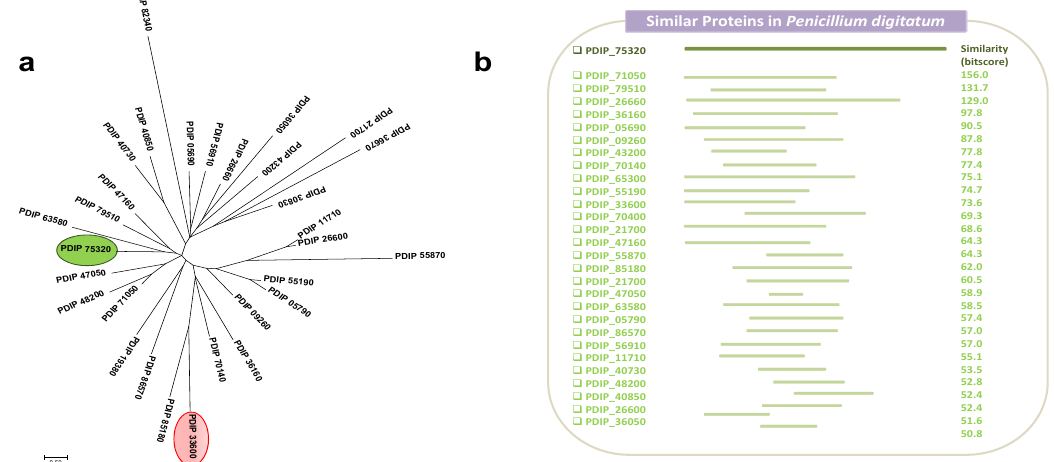
Figure 1. ( a ) Unrooted maximum likelihood phylogenetic tree of selected P. digitatum TF proteins. PdMut3, the new TF described in this study, is highlighted in green, and in red, a TF found in an SSH cDNA library related to P. digitatum virulence. Each branch topology was found 100% of the time during bootstrap analysis. The tree is drawn to scale, with branch lengths measured in the number of substitutions per site. NCBI accession number is indicated for each TF protein. ( b ) Set of proteins within P. digitatum Pd1 that encode the same type of transcription factor corresponding to type III. The regions of greatest similarity are indicated.